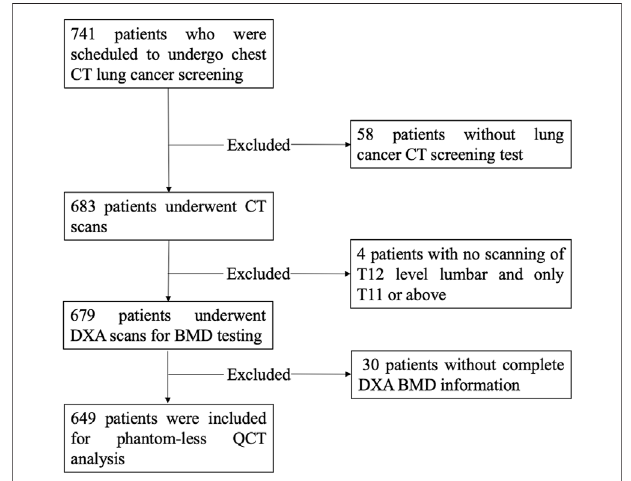
FIGURE 1 | Flow chart of the inclusion